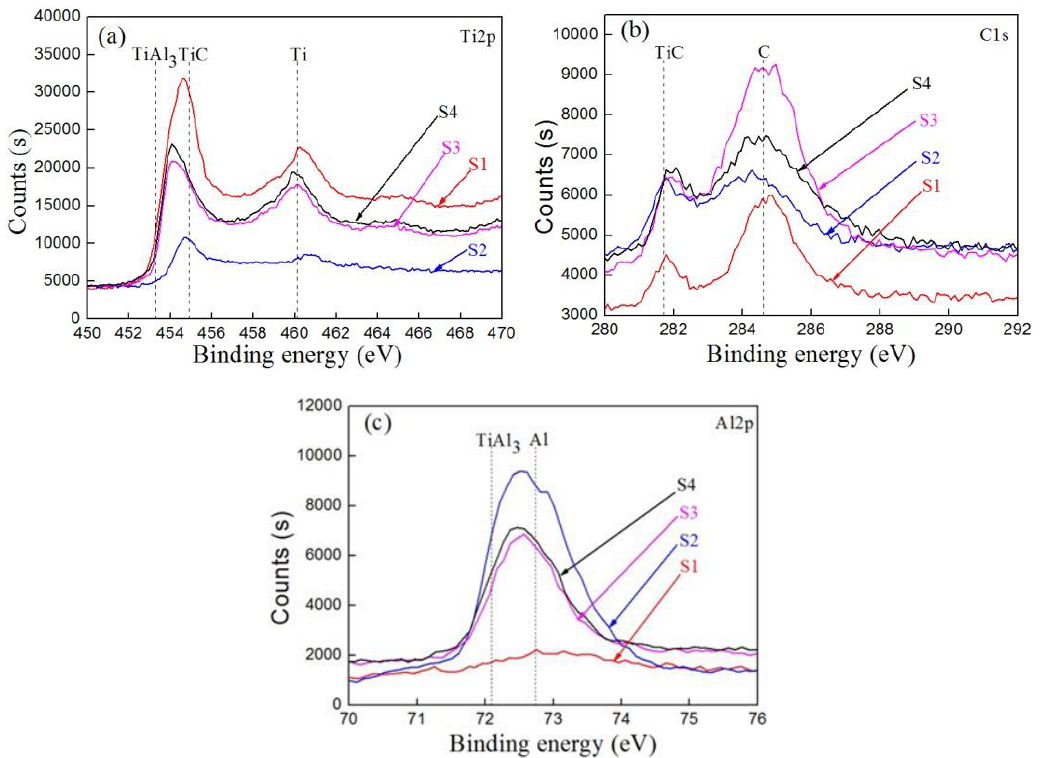
Figure 6. X-ray photoelectron spectroscopy of samples S1–S4: ( a ) Ti2p, ( b ) C1s, ( c ) Al2p.